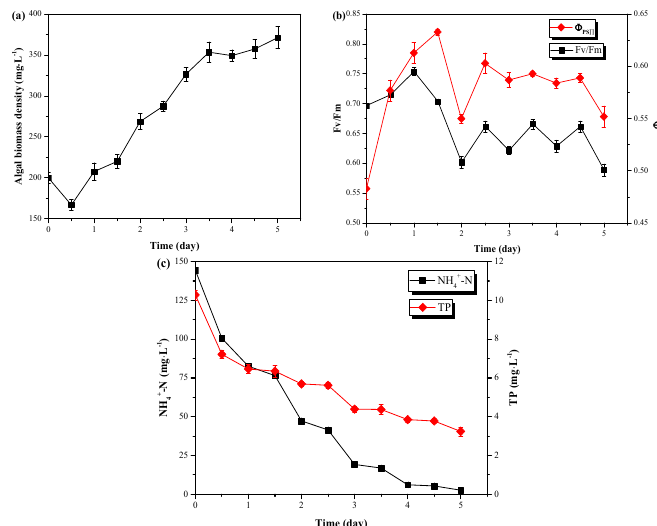
Figure 4. The changes of C. vulgaris biomass density (a) and chlorophyll fluorescence parameters (b) as well as nutrients concentrations (c) during outdoor treatment of pretreated pig urine in LRP ‐ enhanced raceway pond. Table 2. Pig urine treatment results in batch mode.